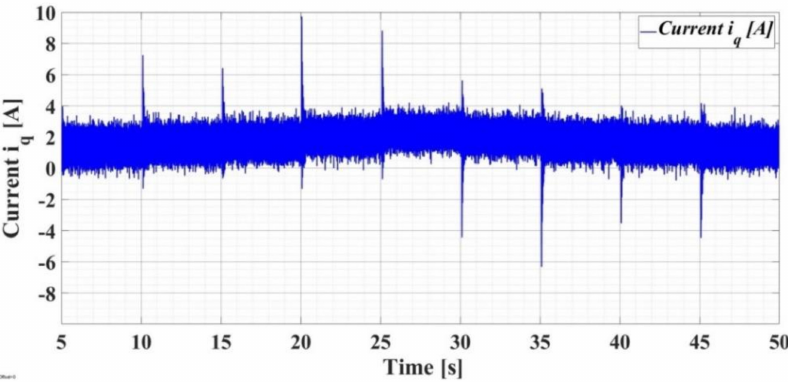
Figure 27. Real-time evolution of current i q for PMSM–CS–CI based on the LQR-type controller.